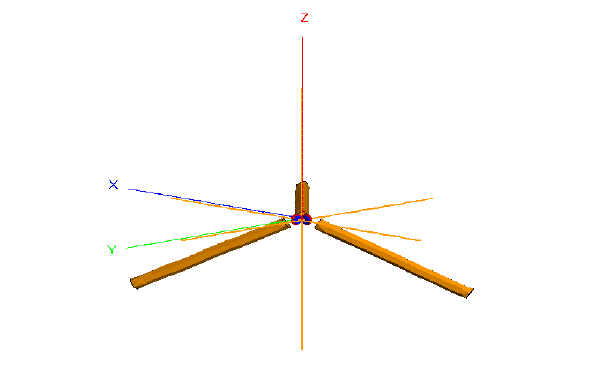
Figure 1. FEKO R (cid:13) model of the Triad Dipole Vector Sensor (TDVS) with three-orthogonally co-located half-wave dipole elements and three copper baluns oriented 45 ◦ away from the radiating elements to minimize coupling